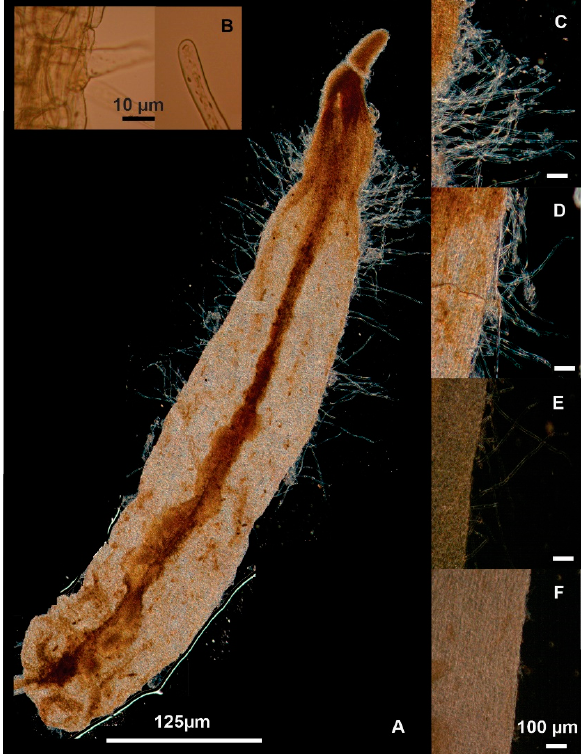
Figure 3. Agrotransformed somatic embryos of T. domingensis after 28 days of coculture with A. rhizogenes K599 ( A ), epidermal tissue with hairy root and a hairy root tip emerging from the infected embryo ( B ), hairy roots density on the surface of somatic embryos infected with A. rhizogenes K599 ( C ), and A4 ( D ) and LBA9402 ( E ) compared with a non-infected control embryo ( F ).